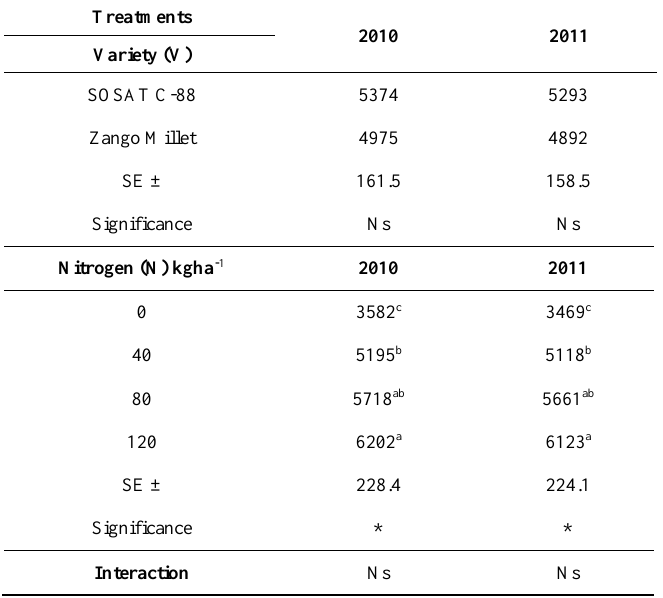
Table 6. Interactions effect of varieties, and Nitrogen on Panicle weight (kgha-1) in 2010 and 2011 cropping seasons at Usmanu Danfodiyo University Teaching and Research Dry Land Farm, Sokoto Treatments